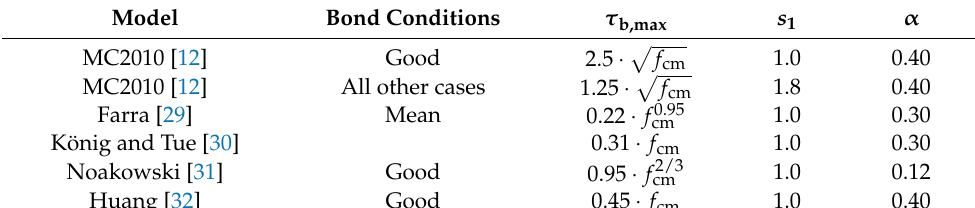
Table 1. Parameters for the ascending branch of the bond–slip relationship for normal-strength concrete. Model Even if the real bond behaviour differs significantly from the bond–slip relationship in Equation (14), user-defined bond–slip relationships can be defined in the CPM using slip values and the corresponding bond stress values. Between the points, a linear interpolation is used to determine the missing values. The only prerequisite here is the starting point at the coordinate origin ( τ b ( s = 0) = 0). An exemplarily user-defined bond– slip relationship is shown in Figure 10b for a splitting failure.